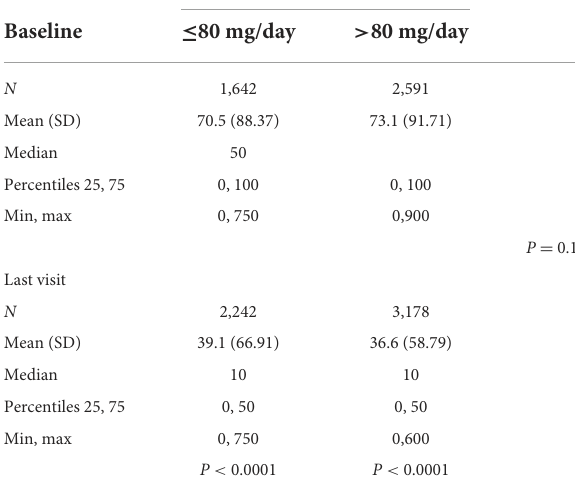
TABLE 3B Alcohol consumption for the overall population – maximum recorded dose.